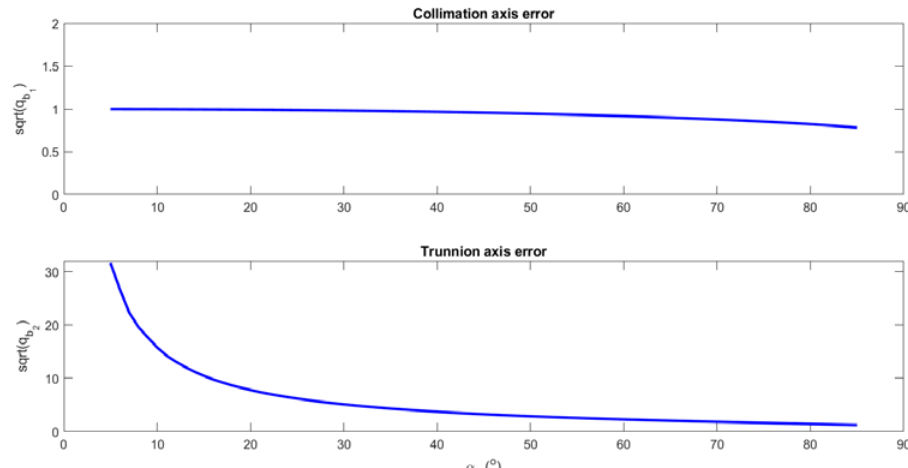
Figure 10. Square roots of the predicted cofactors for the collimation axis error and trunnion axis error terms as functions of the shape parameter α 0